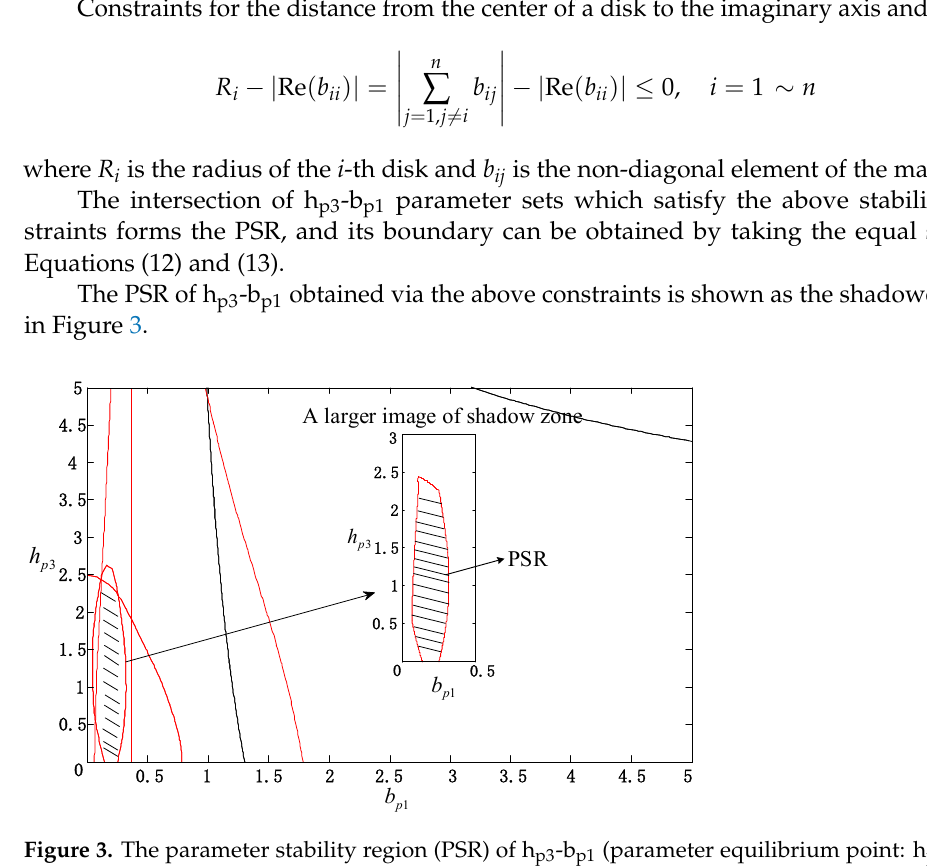
PSR obtained by proposed method Figure 4. The PSR obtained by point-wise calculation of eigenvalues and proposed method. In Figure 4, the PSR obtained by the point-wise calculation of eigenvalues is sur- rounded by the blue line and the coordinate axis, and the black shadowed area is the PSR obtained by the proposed method. It can be seen that the PSR obtained by the proposed method is located inside the point-wise PSR, which illustrates the effectiveness of the proposed method. However, on the other hand, it reflects the relative conservatism of the proposed method, which is analyzed in Section 2.2. The system state matrix is related to the system operating status (power flow). When the operation mode of the power system is different, the system state matrix varies sub- sequently, and the PSR need to be re-constructed according to the updated system state matrix in the exact same method.